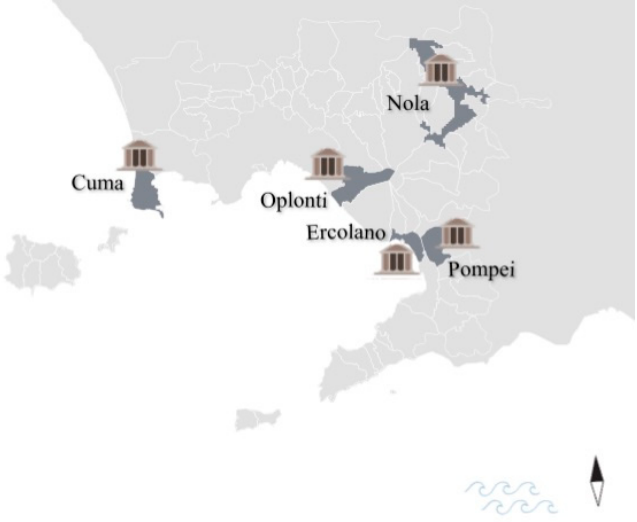
Figure 1. Location of the sampling site of UNESCO heritage monuments in the bay of Naples, Campania, Italy.